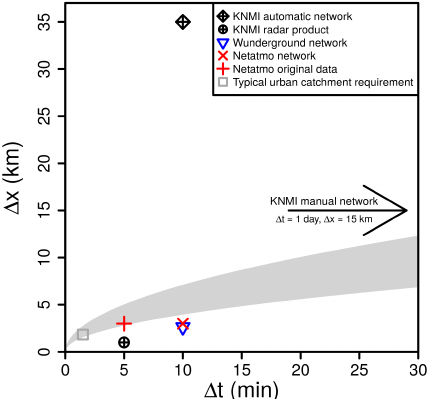
Figure 1. Temporal and spatial resolution of unfiltered rainfall mea- surements in the Netherlands with PWS network obtained via Ne- tatmo API, WunderMap API and the potential availability of Ne- tatmo measurements, as well as the resolution of KNMI’s automatic and manual rainfall measurement network and radar product. The curve represents a relation between the temporal and the spatial res- olution of rainfall measurement required for urban hydrology as de- termined by Berne et al. (2004) for Mediterranean climate, where the square represents the value for an urban catchment with surface area of 0.1km 2